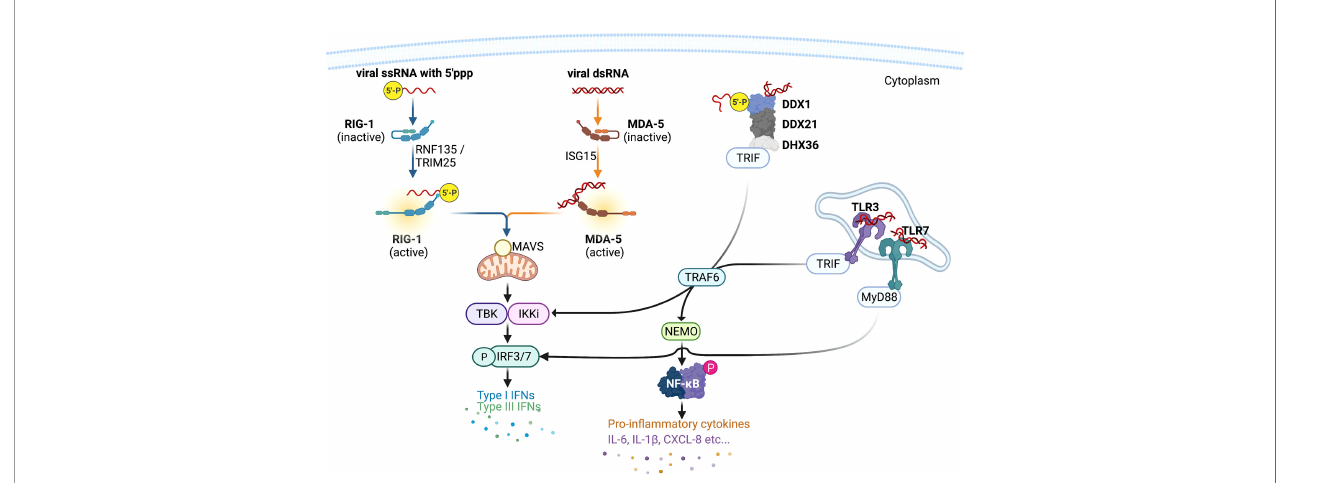
FIGURE 1 | Host intracellular viral RNA recognition and innate immune signalling network. Pattern recognition receptor RIG-I recognises in fl uenza virus ssRNAs with 5` triphosphate group, whereas MDA5, DDX1-DDX21-DHX36 complex, and TLR3 recognises viral dsRNAs. Once engaged with viral RNAs, RIG-I and MDA5 are activated by adaptor proteins RIPLET and TRIM25 and ISG15, respectively, and then initiates the production of type I and III interferons (IFNs) via the mitochondrial antiviral (MAVS) adaptor protein and transcription factor IFN-regulatory factor (IRF)3. DDX1-DDX21-DHX36 complex and TLR3 induces the expression of both type I and III IFNs and pro-in fl ammatory cytokines [interleukin (IL)-6, IL-1 b , etc … ] via the adaptor TRIF and the transcription factors IRF3/7 and nuclear factor kappa-light- chain-enhancer of activated B cells (NF- k B). This fi gure was created with